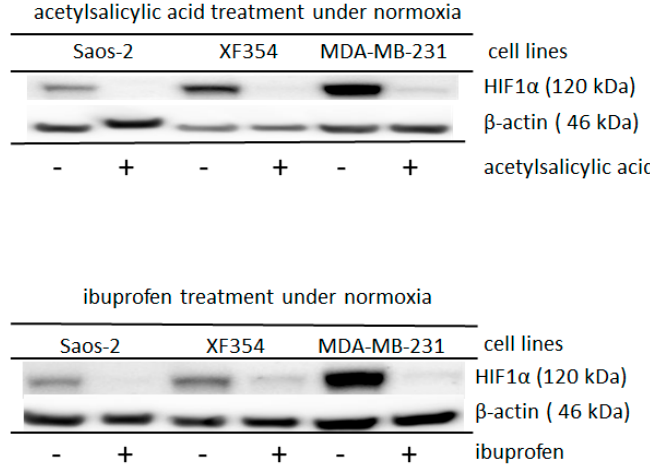
Figure 3. Altered HIF1 α expression after the application of acetylsalicylic acid or ibuprofen in di ff erent cell lines under normoxia. Saos-2, XF354 and MDA-MB-231 cells were treated with 10 mM acetylsalicylic acid or 3 mM ibuprofen in RPMI 1640 medium with 5 mM glutamine under normoxic